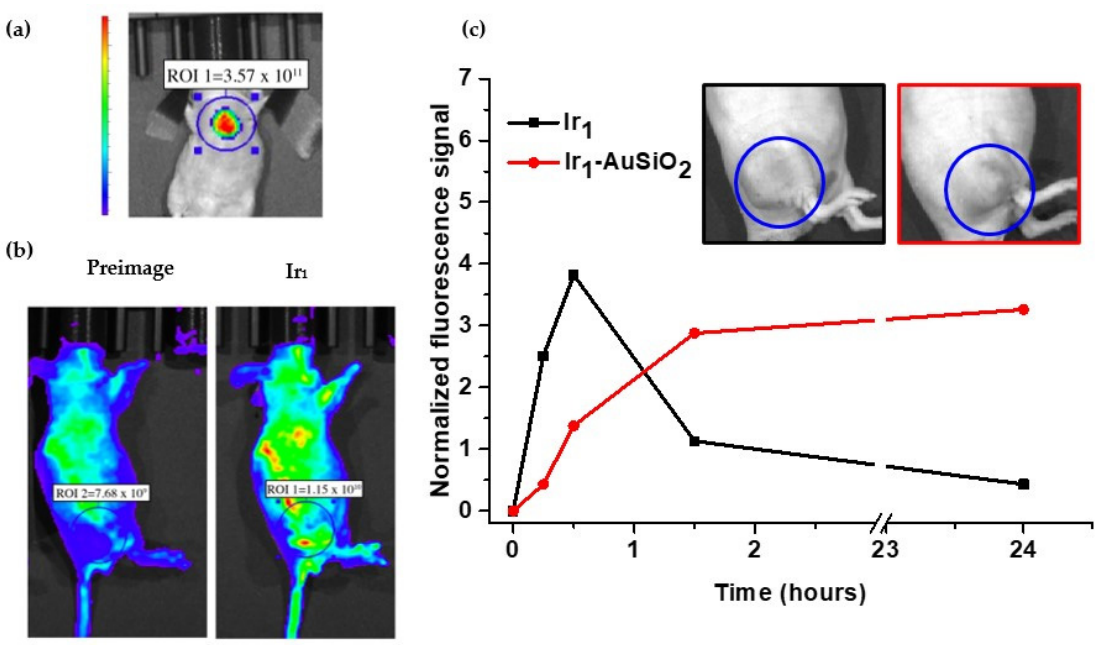
Figure 3. In vivo imaging of mice treated with Ir 1 or Ir 1 -AuSiO 2 . ( a ) Fluorescence image of Ir 1 injected subcutaneously into the mouse. The fluorescence signal intensity, measured as photon counts, is shown as color scale bar (radiant efficiency from 5.27 × 10 9 (blue) to 4.74 × 10 10 (red)); ( b ) representative real-time in vivo fluorescence images pre and 30 min post-injection of Ir 1 into the GBM mass; ( c ) normalized fluorescence signals acquired before time course and after injection of Ir 1 (black) or Ir 1 -AuSiO 2 (red) into the GBM mass. Inset: bright field image of the flank tumor. The blue circle in all the images identifies the region-of-interest (ROI).